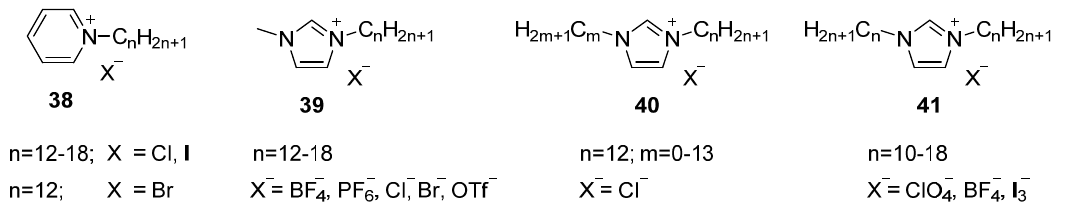
Figure 9. Pyridinium ( 38 ) and imidazolium-based ( 39 – 41 ) ILCs with one or two long aliphatic tails.